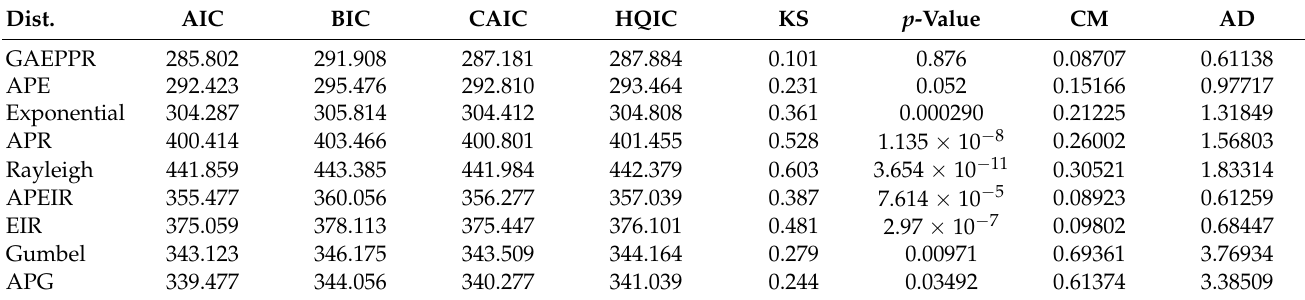
Table 5. DMs and GFMs of the competing models for the runoff